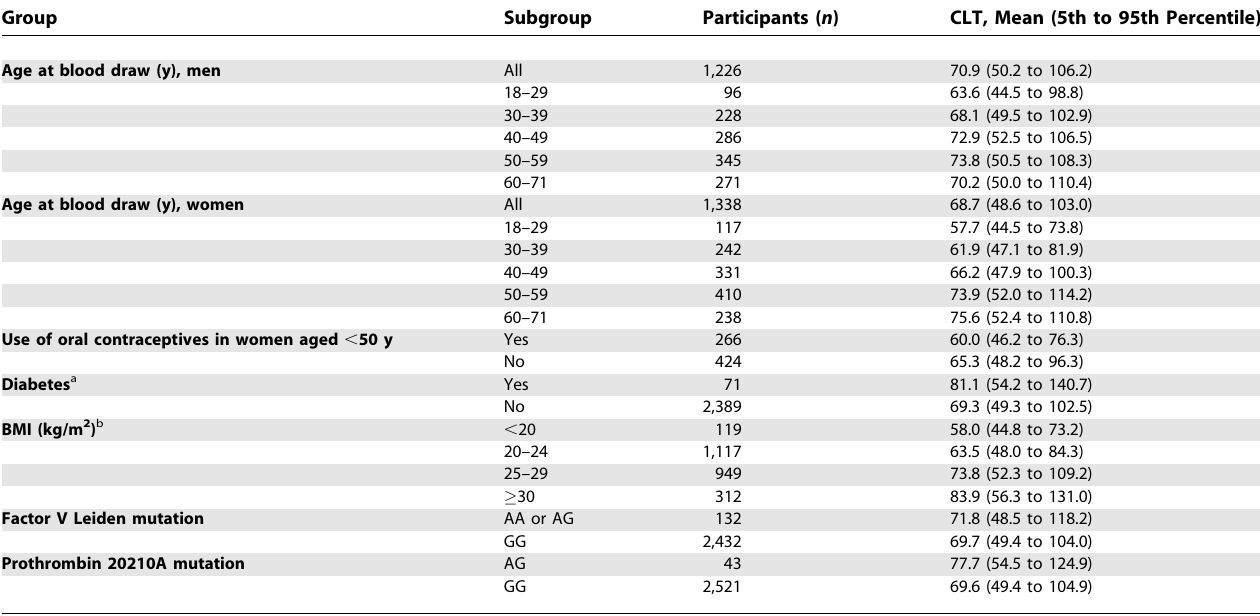
Table 5. Clot Lysis Times in All Control Participants Group Subgroup Participants ( n ) CLT, Mean (5th to 95th